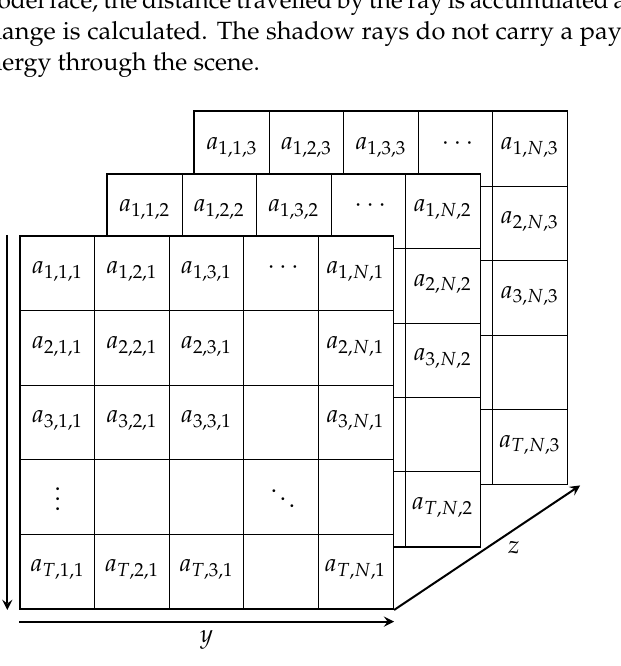
Figure 3. Structure of intermediate raytracing results matrix for three bounces. Further multi-bounce interactions can be added by extending the z